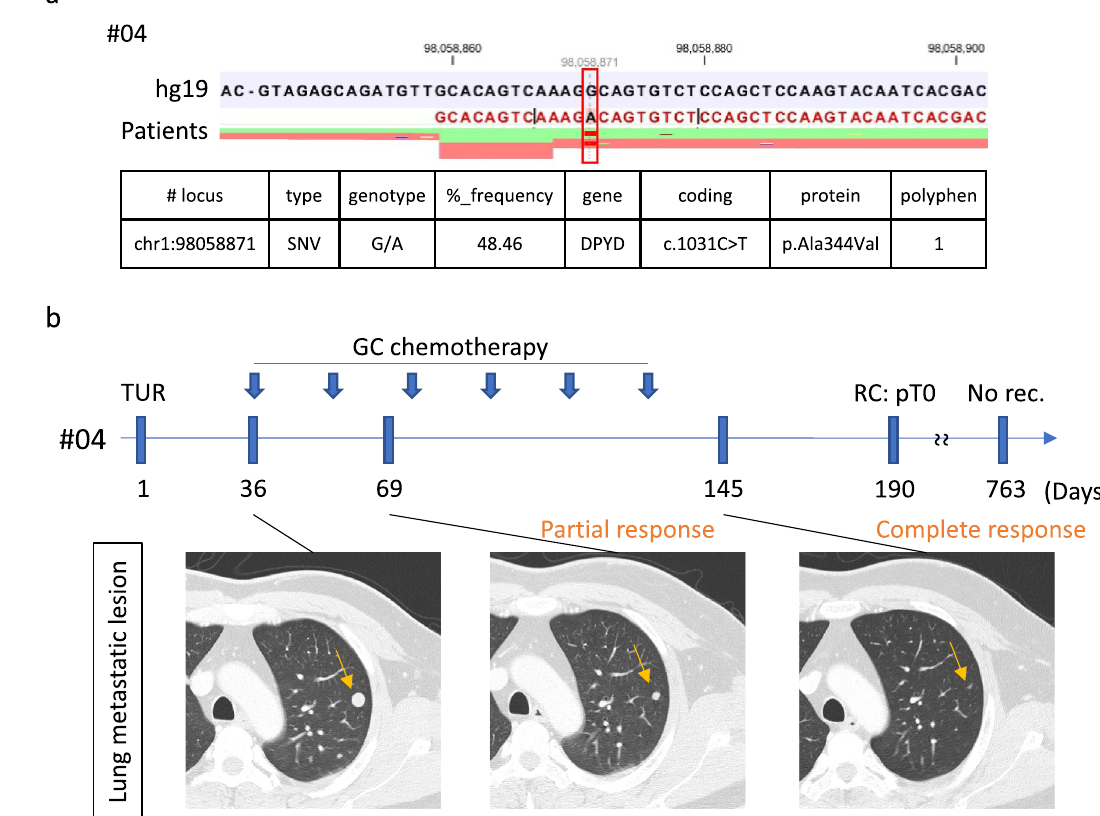
indicates the forward and reverse read depth, respectively. Red band indicates mutated nucleotide. ( b ) Clinical course of patient #04 from TUR is shown. GC, gemcitabine/cisplatin; TUR, transurethral resection; CR, complete response; RC, radical cystectomy; No rec., no